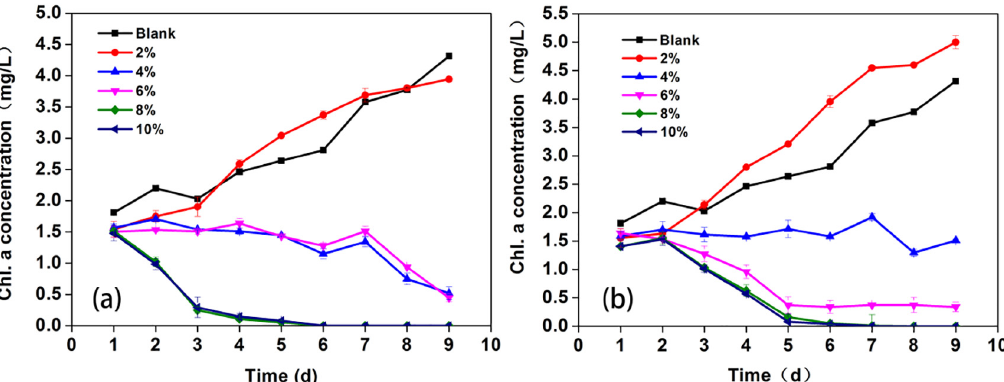
Figure 4. The effects of bacterial culture liquid volume on chlorophyll-a of Microcystis aeruginosa. ( a ) strain 39 # and ( b ) strain 91 # .